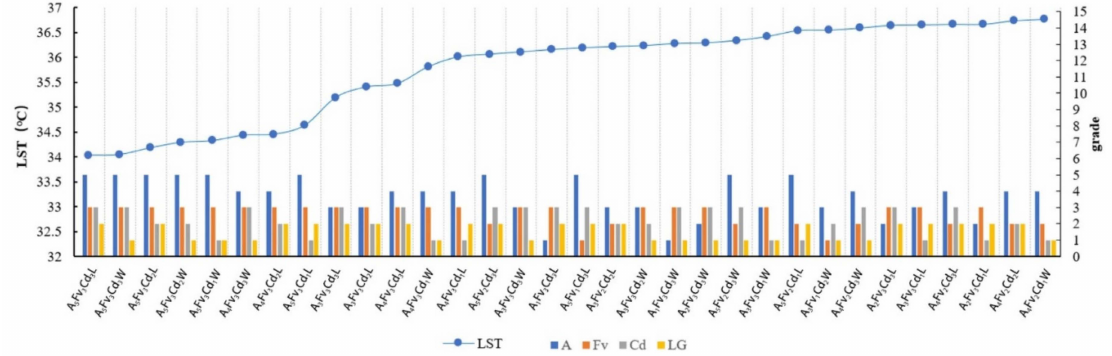
Figure 12. Sorted MG types with LST values lower than 36.8 ◦ C in the Width-II river buffer zone and the linear correlation between the MG types and their LST values.